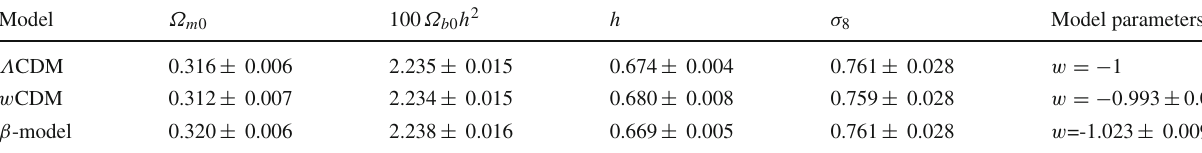
Table 2 A summary of mean values of background parameters calculated by using MCMC chains Model